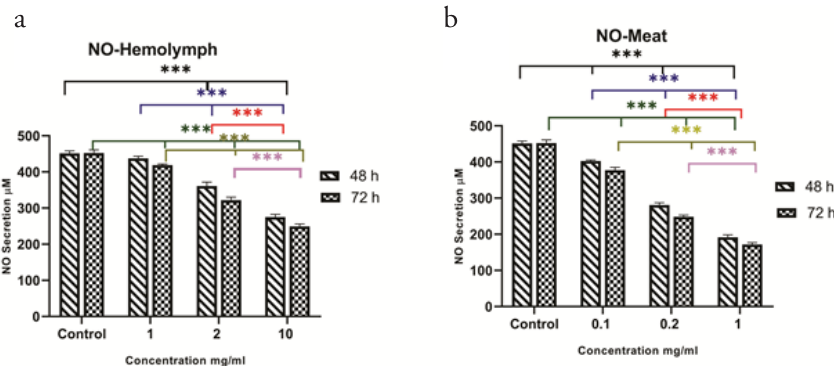
Figure 7. The amount of NO (µM) secretion of 4T1 cells after 48 and 72 h of treatment with different concentrations of crab hemolymph (a) and meat extract (b). NO secretion of 4T1 cells decreased in dose and time-dependent manner ( P ≤ 0.001 ***). The data is shown as mean ± SD.